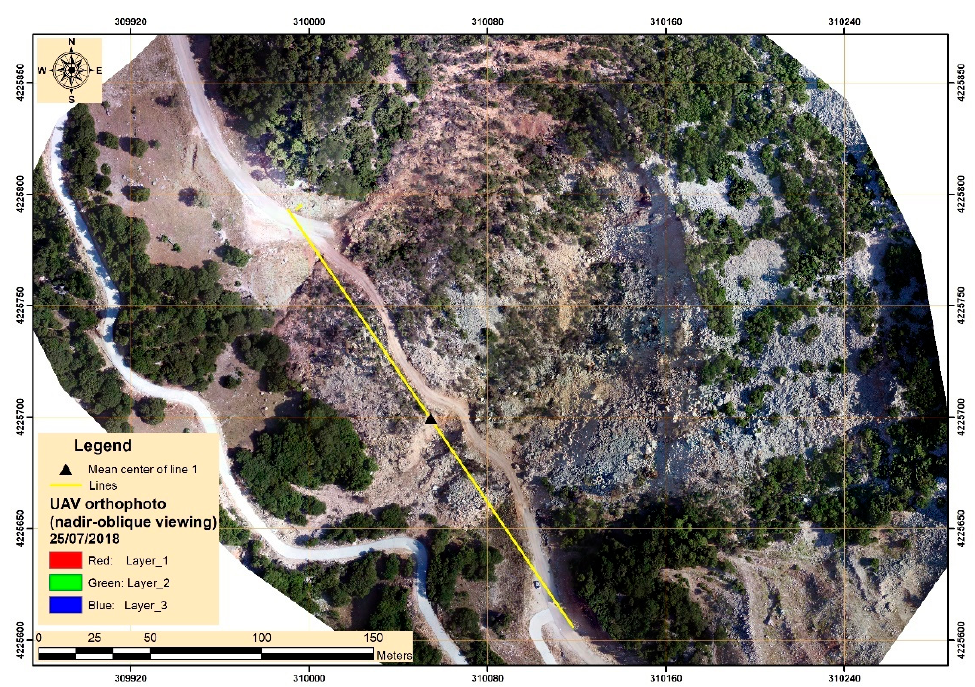
Figure 9. Location of mean center of line 2. Table 6. Near distances of mean centers from the reference mean centers of lines 1 and 2.